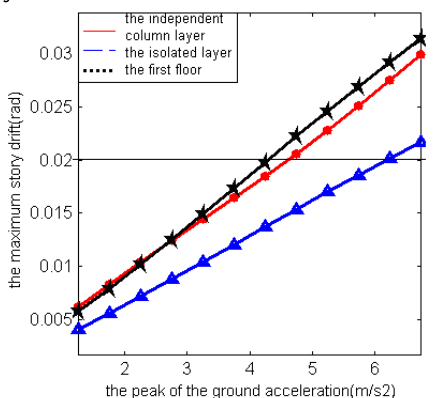
Fig.7a Maximum story drift as function of the magnitude of the ground acceleration